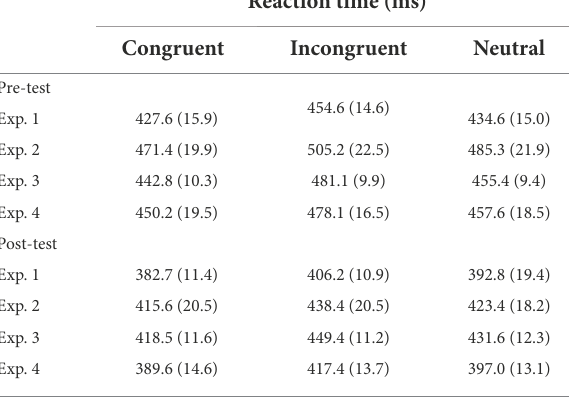
TABLE 1 Reaction time in free choice trials in four